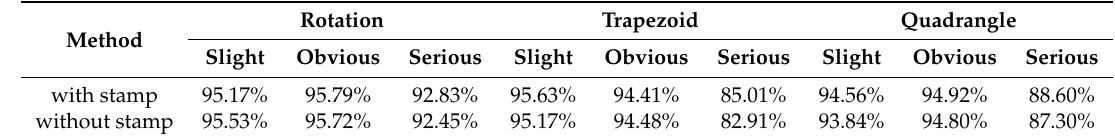
Table 5. Accuracy of